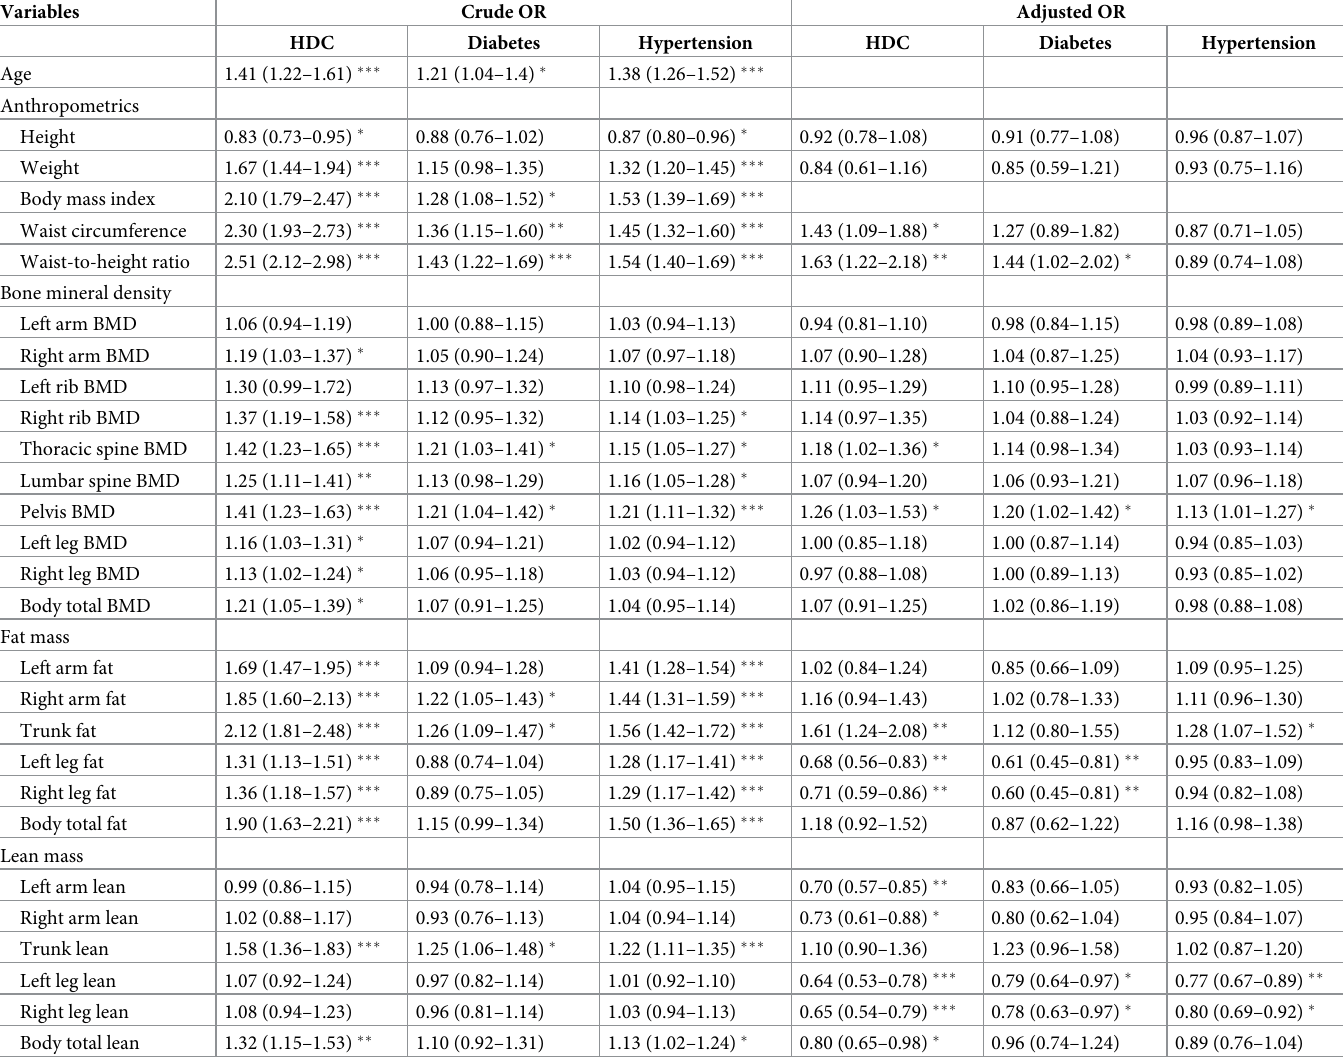
Table 2. Associations of HDC, diabetes, and hypertension with anthropometrics, BMD, fat and lean mass in